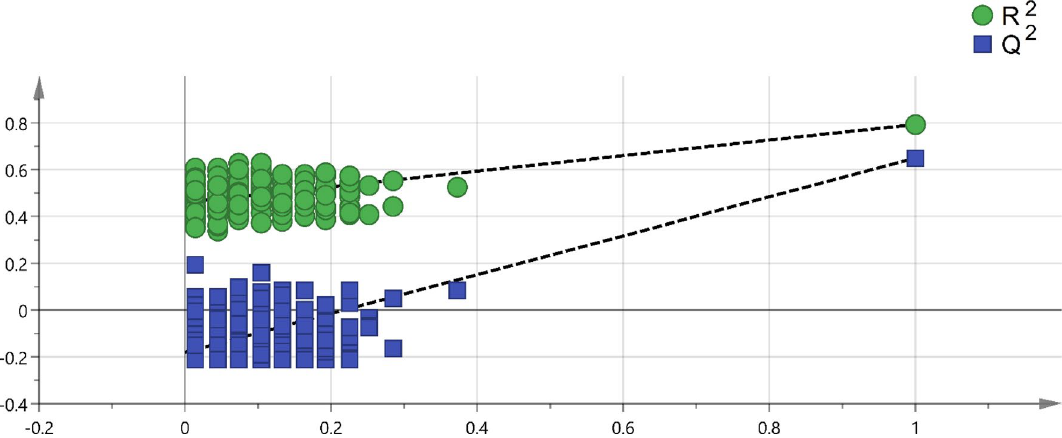
Figure 3. Permutation test of PLS-DA with VIP scores greater than 1. A permutation test with 200 random permutations and two components in the PLS-DA model showed R 2 = 0.79 (green triangles) and Q 2 = 0.65 (blue squares); values from the permuted test (bottom left) were significantly lower than the corresponding original values (top right).